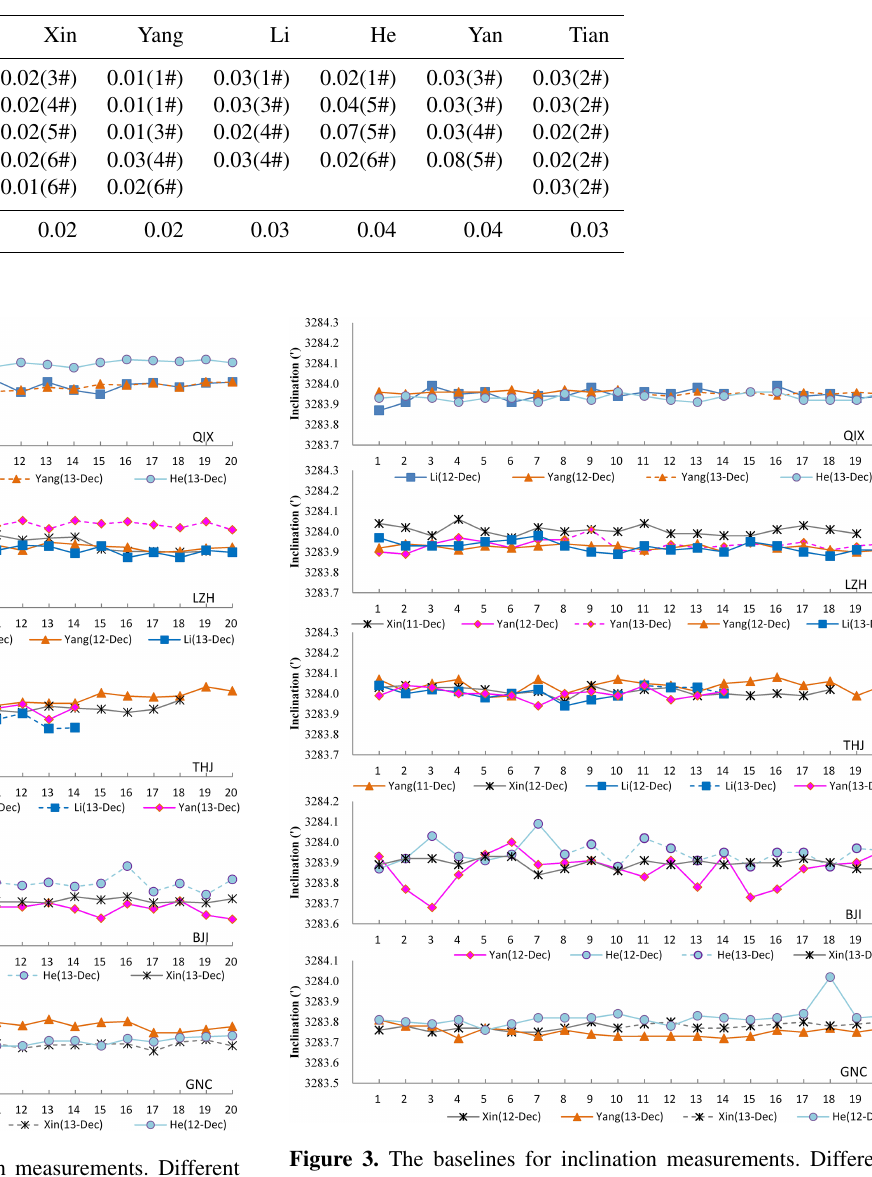
Figure 2. The baselines for declination measurements. Different symbols (or colors) represent different observers, and different line styles represent that the same observer made absolute measure- ments on different observation dates.